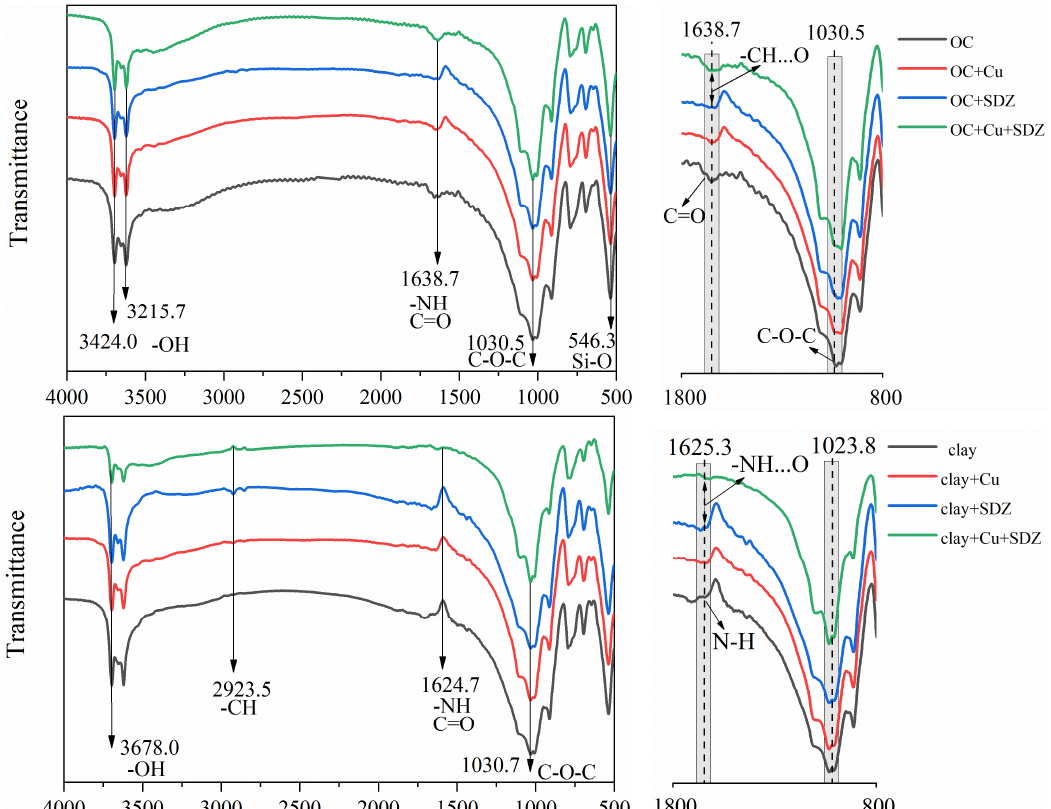
Figure 3. The FTIR spectra of OC and clay before and after the reaction with SDZ and Cu 2+